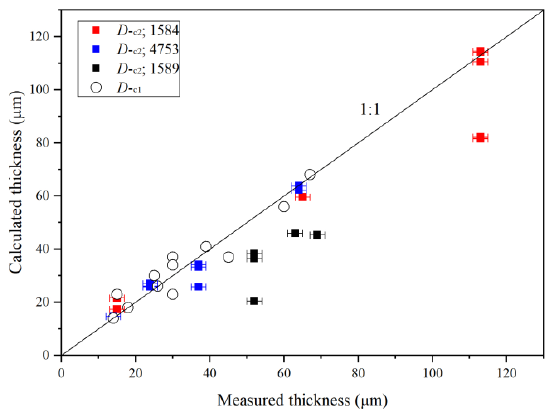
Figure 3. Calculated thickness ( D -c1 or D -c2 ) vs. measured thickness ( D -m ) for thin sections of Rw with various compositions. D -c1 is calculated using Equation (3), whereas D -c2 is calculated using Equation (4). Data sources for the D -c1 calculations are this study (4753-05-01 with D -c1 = 14.0 μm and 1584 -03- 01 with D -c1 = 22.5 μm; see Table 1 for other details), Koch -Müller et al. [16] (MA062, with D -m = 25(5)